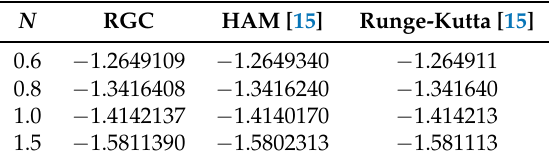
Table 1. Comparison of RGC, HAM and Runge-Kutta solution of f (cid:48)(cid:48) ( 0 ) for various values of N while Sc = 0.24 and K = 0.2.